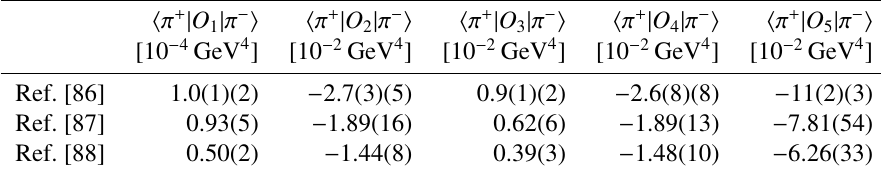
Table 2. Short-distance matrix elements for π − → π + e − e − at scale μ QCD [87, 88] and using SU(3) relations